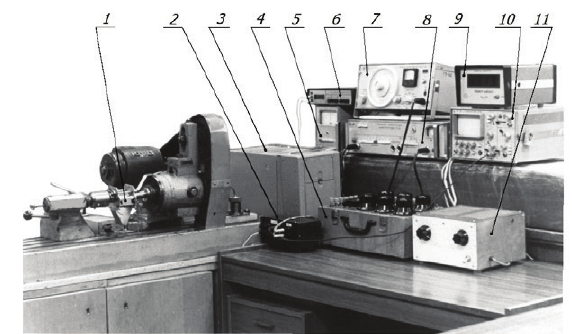
Figure 5. Test rig for tribological investigations: 1 − tribometer; 2 − block with isolating transformer, half bridge of resistances and diode bridge; 3 − light-beam oscillograph H 115; 4 − resistance control set; 5 − the electronic block of the inductive sensor; 6 − millivoltmeter;